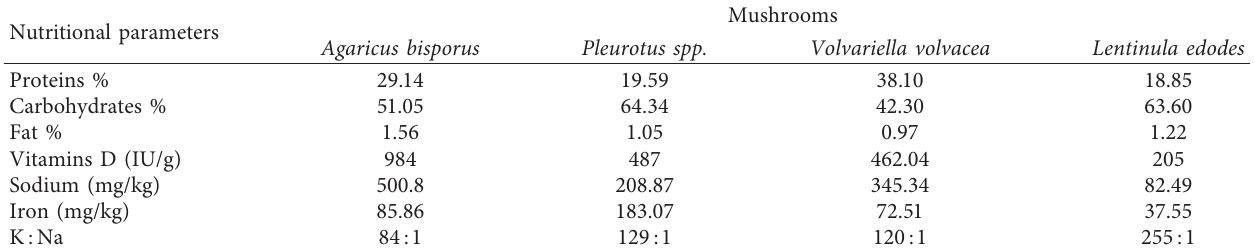
Table 1: Nutritional value of some commercial edible mushrooms (on dry wt. basis)